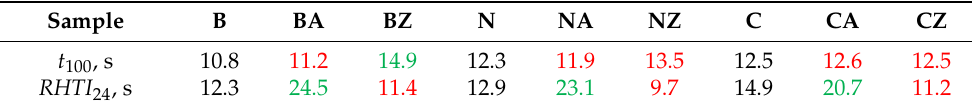
Table 3. Results of measurements of resistance to contact heat and resistance to radiant heat.